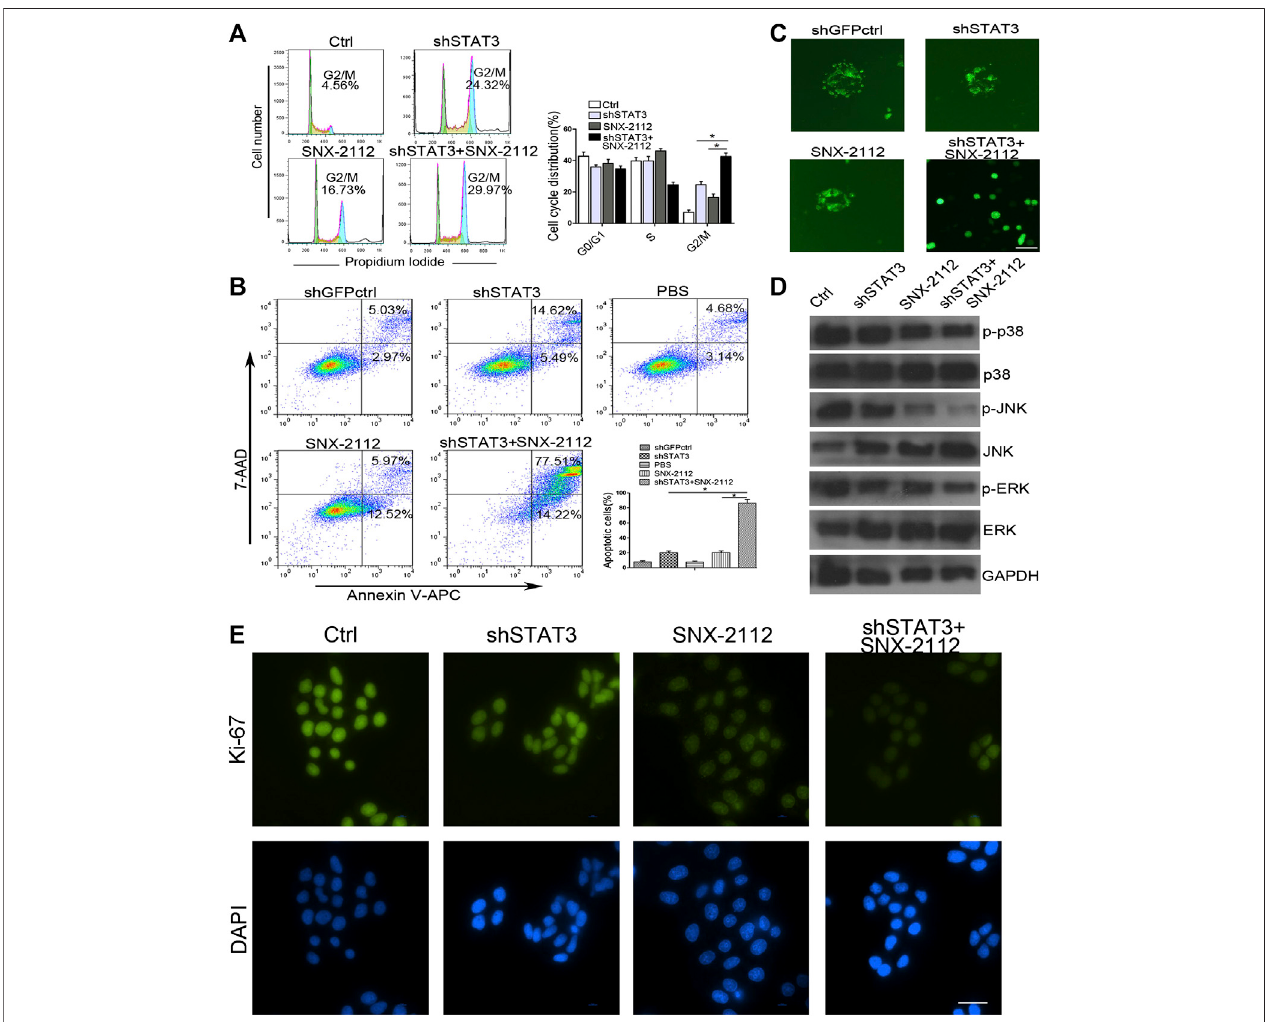
FIGURE 4 | Combination treatment with SNX-2112 and shSTAT3 induced ECSLCs apoptosis and cell cycle arrest (A) Flow cytometry analysis of cell cycle of the ECSLCs after treatment with shSTAT3 for 72 h and with 0.2 μ M SNX-2112 for 24 h. The cell cycle distribution was analyzed by fl ow cytometry. Vertical bars represent mean ± SD from three independent experiments. (B) The apoptosis of ECSLCs treated with shSTAT3 for 72 h and 0.2 μ M SNX-2112 for 24 h was analyzed by fl ow cytometry. The data were from three independent experiments. (C) The sphere formation size detection of ECSLCs. The ECSLCs were treated with shSTAT3 for 72 h and 0.2 μ M SNX-2112 for 24 h. Then the ECSLCs were subjected to normal medium for approximately 14 days. The medium was changed every 3 days. Scale bar, 50 μ m. (D) Western blot analysis of ECSLCs treated with shSTAT3 for 72 h and 0.2 μ M SNX-2112 for 24 h. The level of p38, ERK, and JNK were analyzed by western blot. GAPDH was used as a loading control. (E) Ki-67 proliferation analysis of ECSLCs treated with shSTAT3 and 0.2 μ M SNX-2112 for 24 h. The cells were collected and incubated with Ki-67 antibody. Scale bar, 50 μ m.